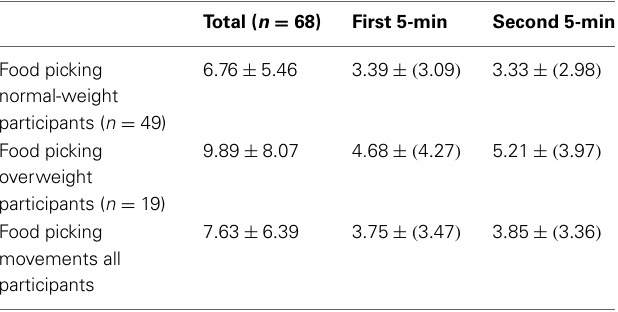
Table 2 | Food picking movements measured by the first and second 5-min of the social interaction 1 .